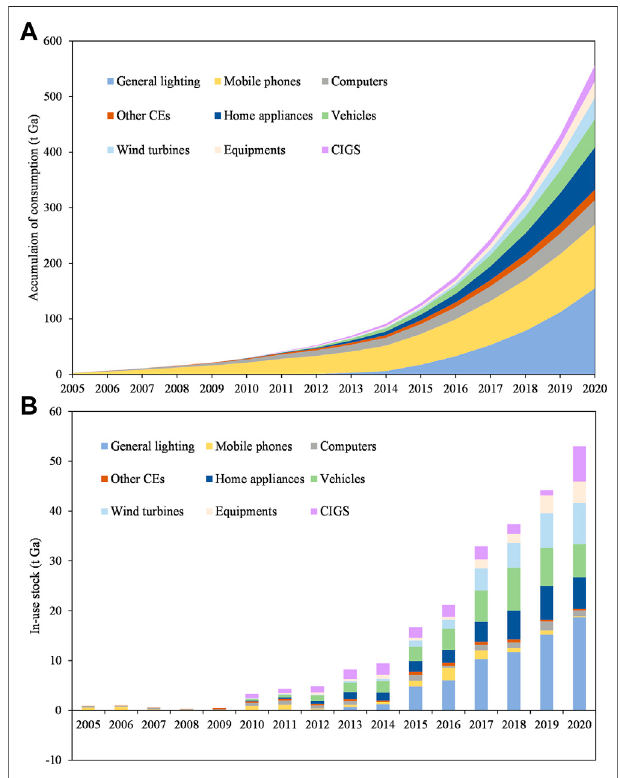
FIGURE 8 | Dynamics of (A) accumulation of gallium consumption in Chinaduring2005 – 2020 (B) yearlynetincreasedgalliumin-usestockinChina during 2005 – 2020.